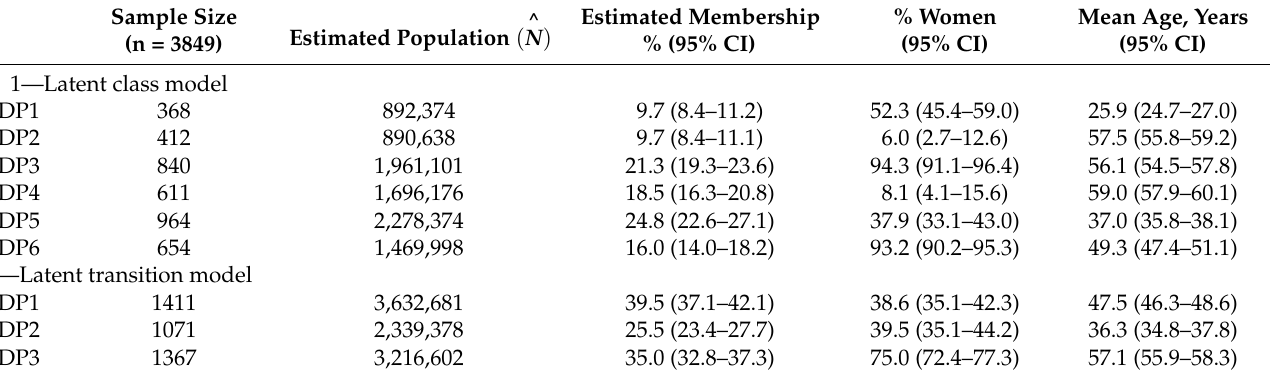
Table 1. Sample size and estimated percentage of membership in each dietary pattern identified by the two methods: Latent class model and Latent transition model, both with age and sex as concomitant variables. Sample